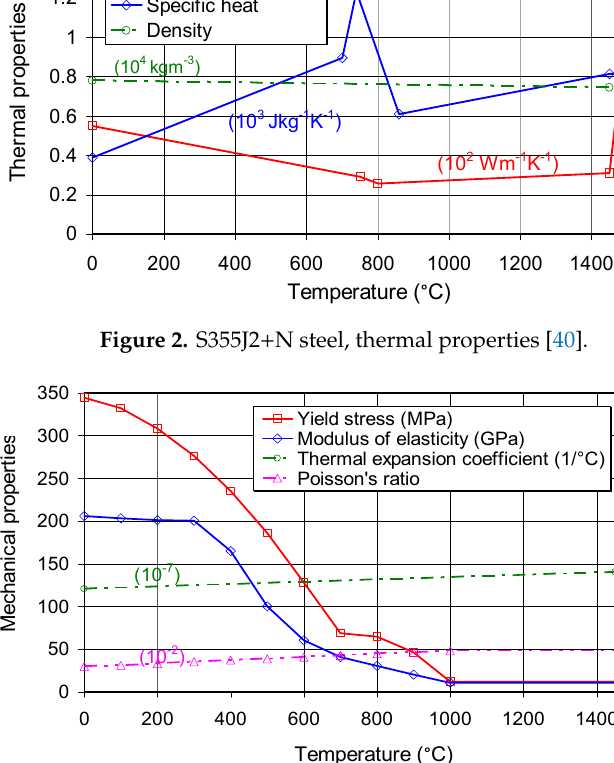
Figure 3. S355J2 + N steel, mechanical properties Figure 3. S355J2+N steel, mechanical properties [40]. Figure 3. S355J2+N steel, mechanical properties [40].